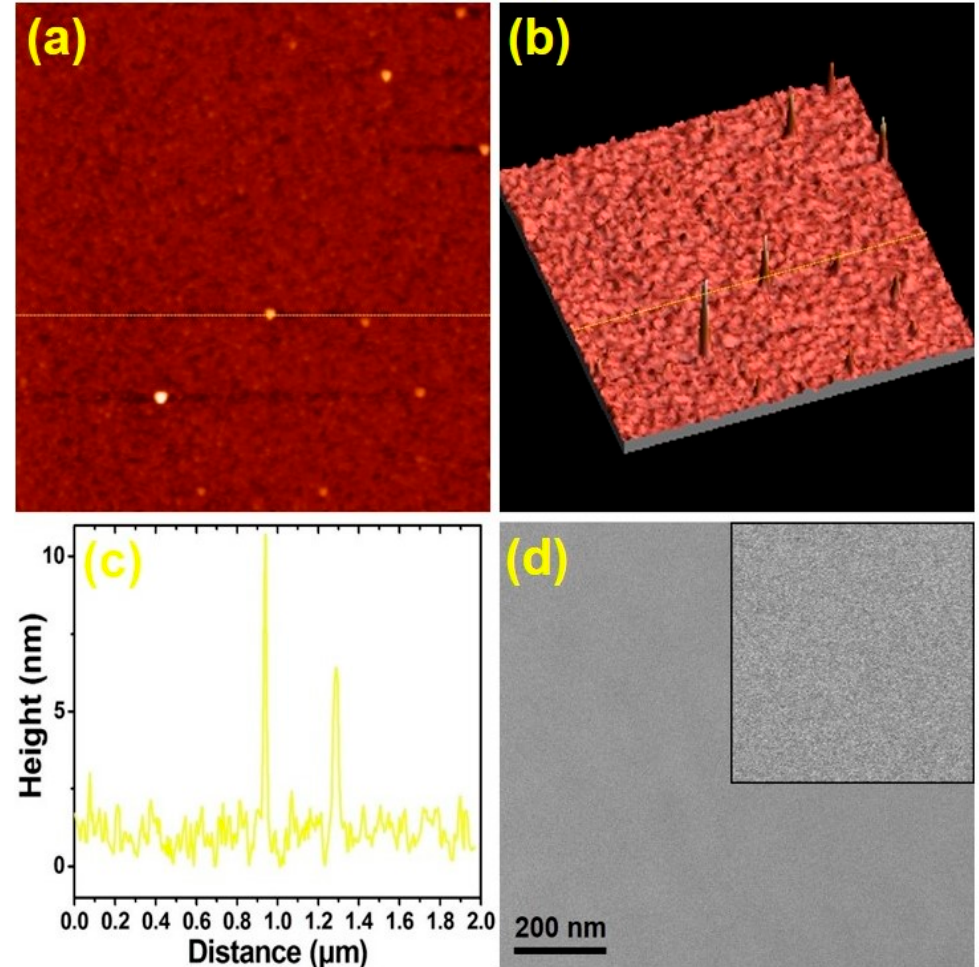
Figure 5. AFM morphology of the Au/CrN films: ( a ) 2D topical image; ( b ) 3D image of ( a ); and ( c ) a line-scan analysis of the Au/CrN films corresponding to ( a , b ). The scan area is 2 × 2 μ m 2 . ( d ) a plan-view of the SEM image; the inset is an enlarged image of the area.